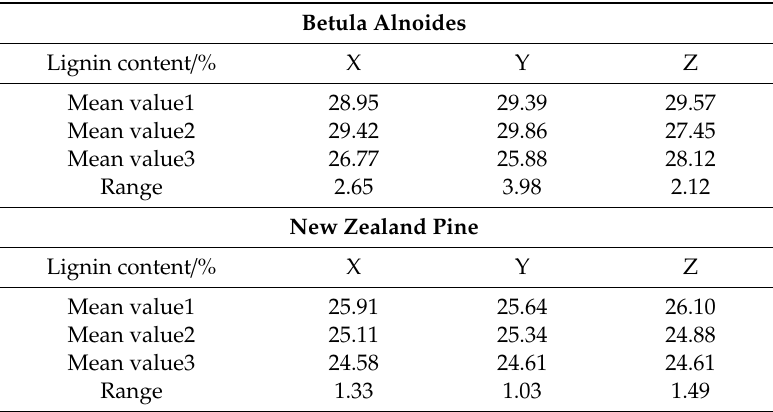
Figure 2. The contents of lignin, cellulose, and hemicellulose in ( a ) Betula alnoides and ( b ) New Zealand pine OW and FW samples. Table 4. Orthogonal test results and range analysis.